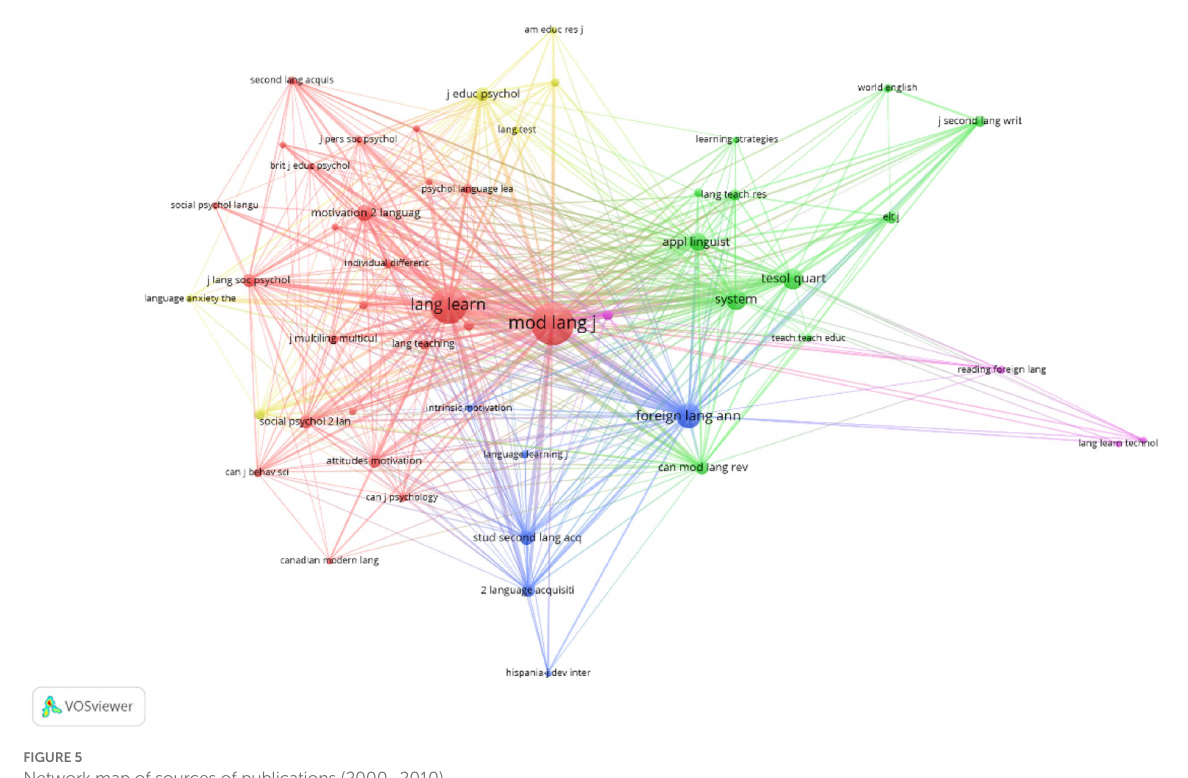
FIGURE 5 Network map of sources of publications (2000–2010).